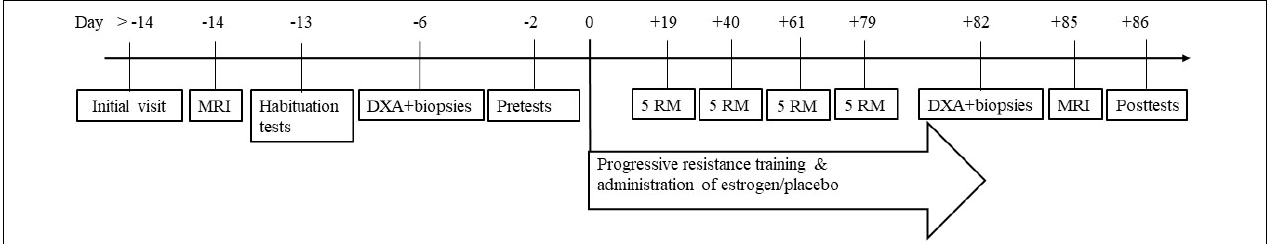
FIGURE 1 | Overview of protocol. Initial visit included measured height, weight, questionnaire, and a screening blood sample. Habituation, pre- and post-test included: five RM (leg press, knee extension, and knee flexion), maximum voluntary isometric contraction, electromyogram, functional tests (sit-and-raise, 6 min walk, countermovement jump, hand and finger strength, and nine-hole-peg-test). MRI, magnetic resonance imaging of legs and DXA, whole body dual-energy-X-ray absorptiometry scan.